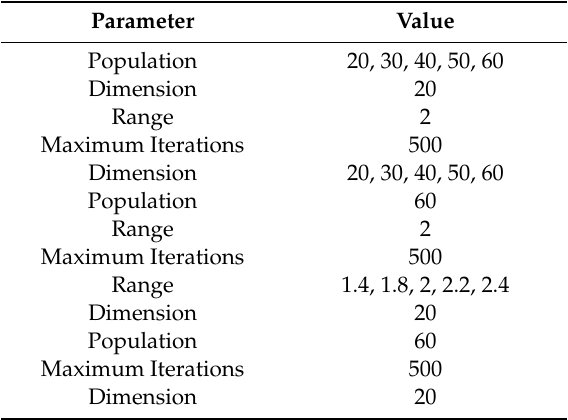
Table 6. Parametric specification of population, dimension and range value for five samples with varied population